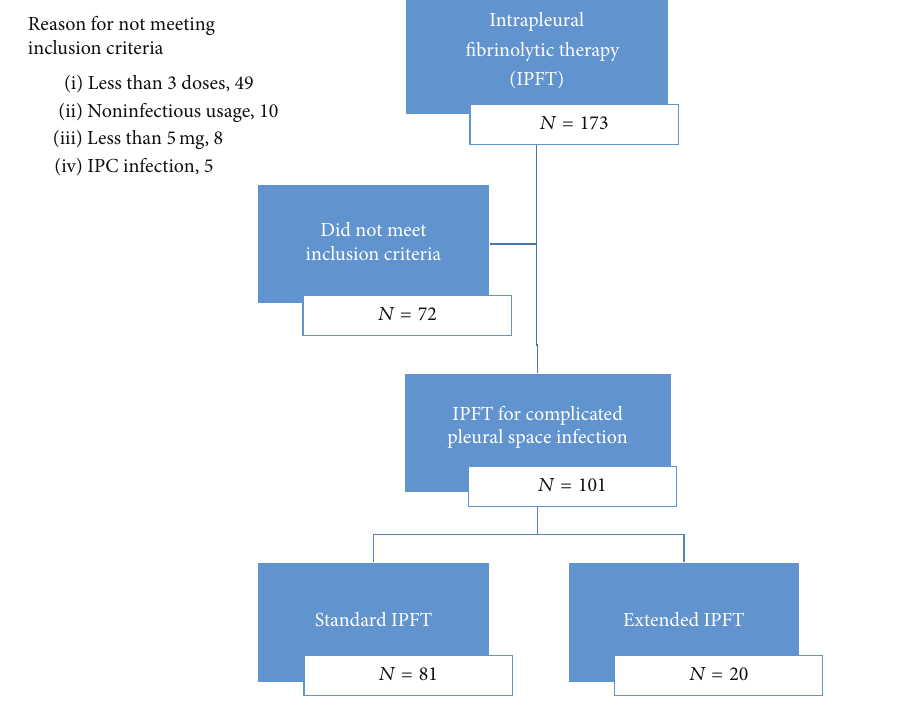
Figure 1: Patient exclusion/inclusion criteria.